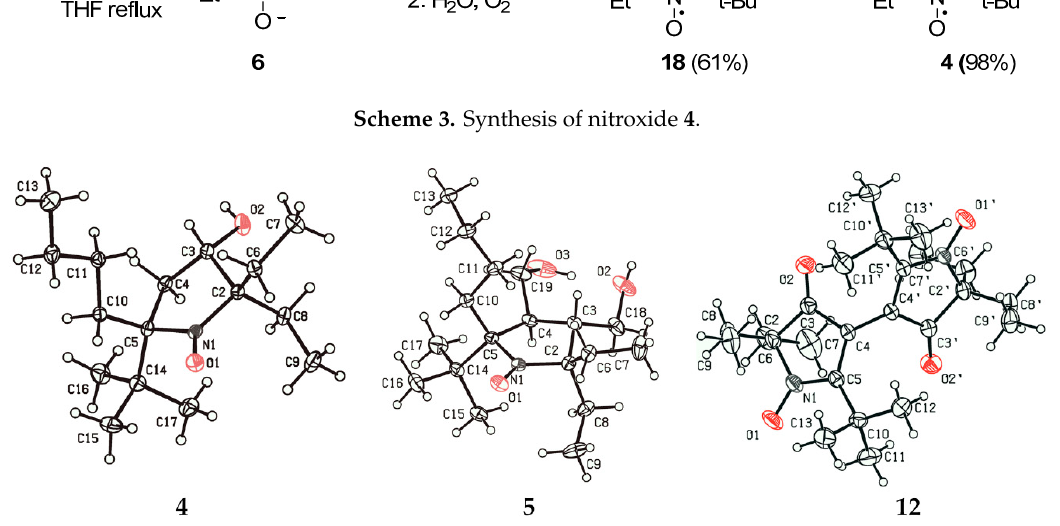
Figure 1. The structures and atom numbering of compounds 4 , 5 , and 12 (the thermal ellipsoids are drawn at the 30% probability level, one of two independent molecules of 4 is shown).